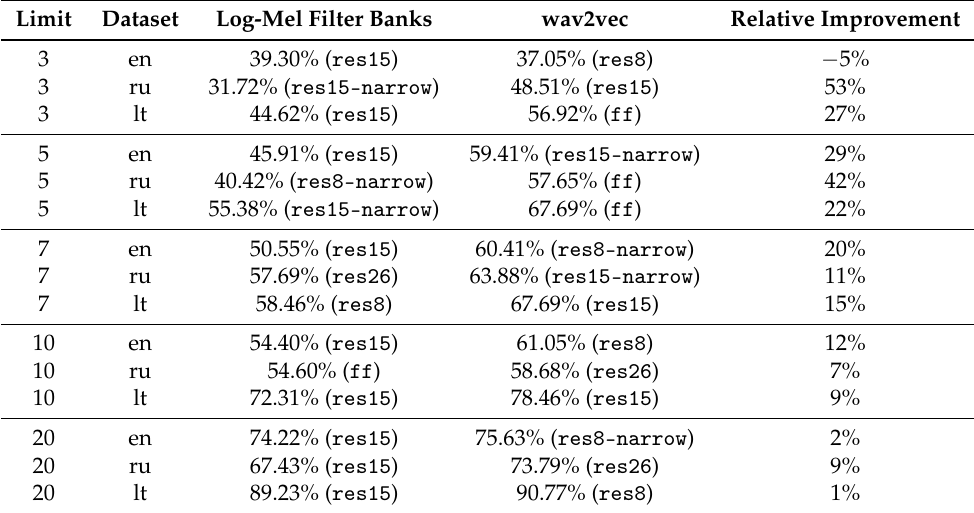
Table 6. Test accuracy on limited datasets for English (en), Russian (ru) and Lithuanian (lt) datasets. The best model by test accuracy is specified in brackets. Note that the limit of 20 is effectively the same as using the whole dataset for the Lithuanian